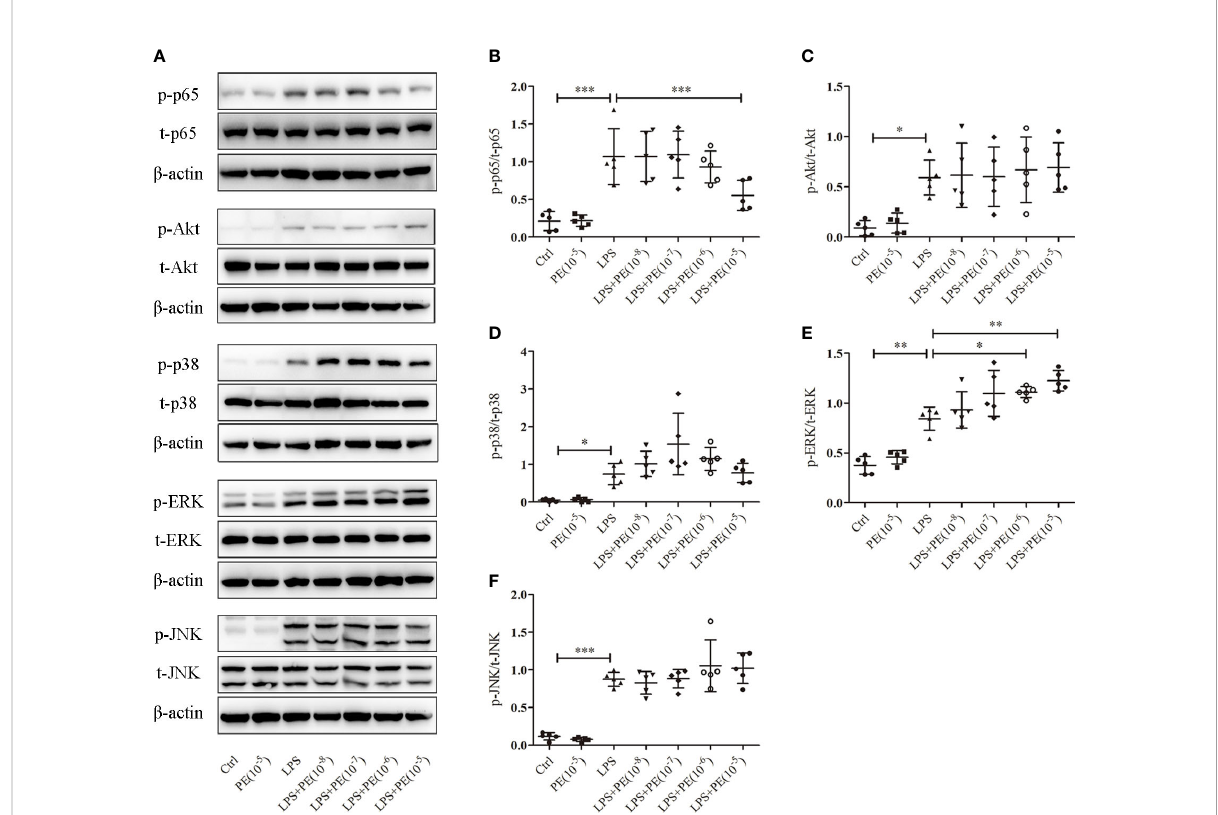
FIGURE 4 Phenylephrine (PE) suppressed NF- k B activation and enhanced ERK1/2 activation in alveolar macrophages stimulated by lipopolysaccharide (LPS). MH-S cells were incubated with PE (10 -8 -10 -5 M) for 30 min, followed by LPS (100 ng/mL) for 30 min. (A) Western blotting was used to evaluate activation of p65, Akt, p38, ERK1/2, and JNK. Phosphorylation of p65 (B) , Akt (C) , p38 (D) , ERK1/2 (E) , and JNK (F) were analysed according to grey values. Data are represented as the mean ± SD, n = 5 per group. * p < 0.05, ** p < 0.01, *** p <